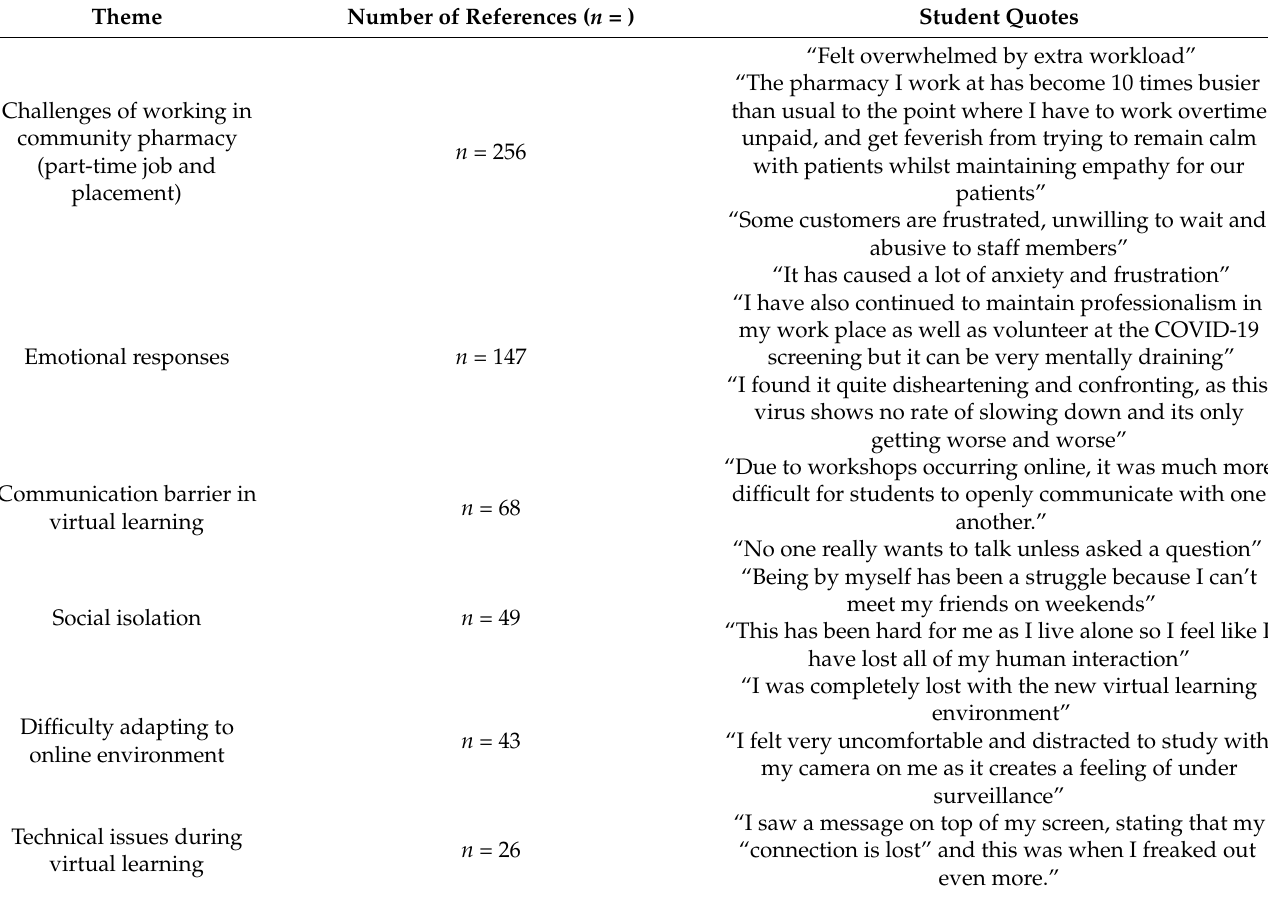
Table 2. The types of challenges that pharmacy students experienced during initial COVID-19